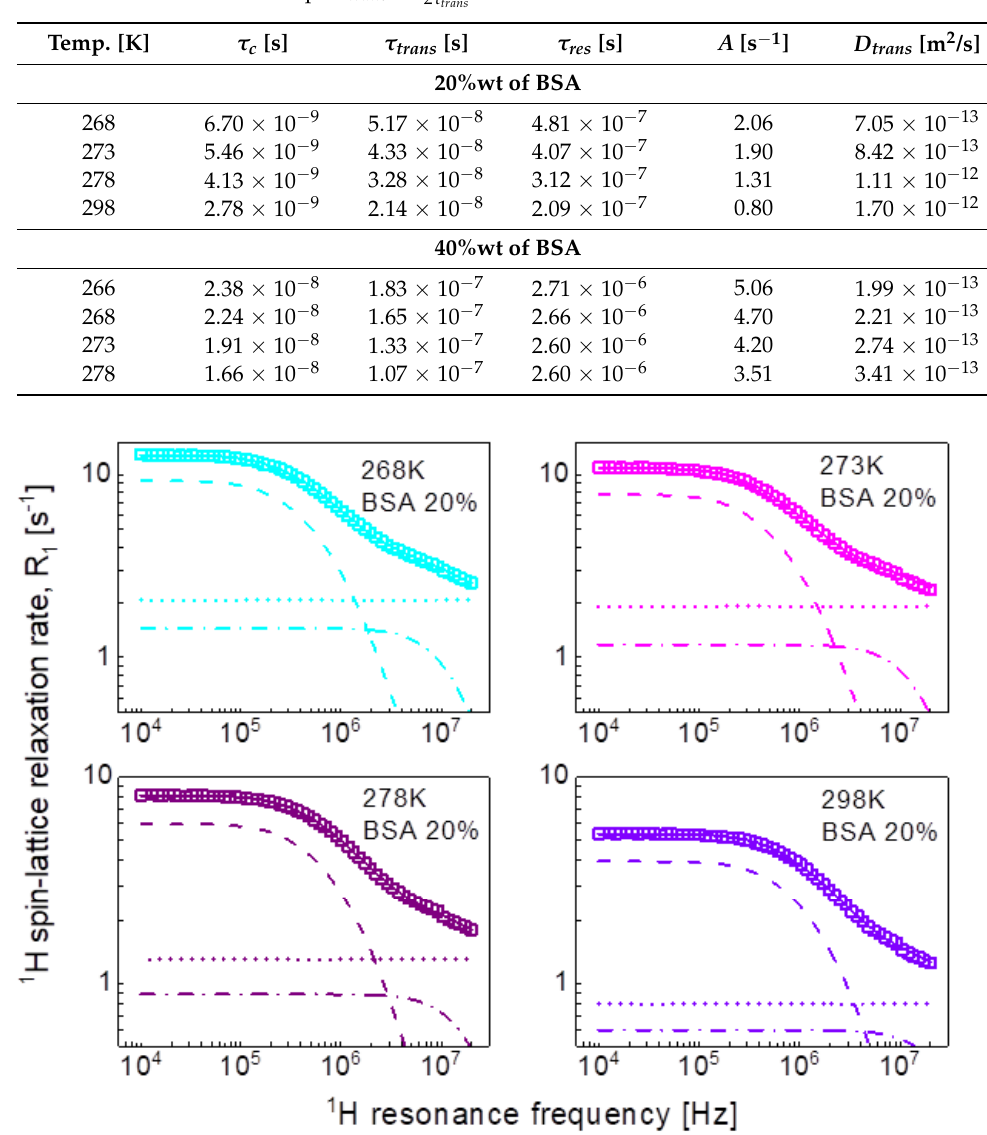
Figure 7. 1 H spin-lattice relaxation data for BSA–water mixture (20%wt of BSA) reproduced in terms of Equation (8); solid line—overall fit decomposed into a term associated with two-dimensional translation diffusion (dashed line), a Lorentzian term (dashed-dotted line) and a frequency independent term (dotted line).